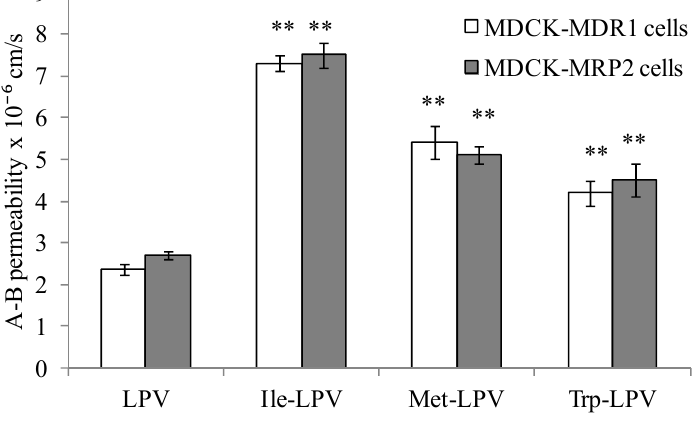
Figure 6. A–B permeability of LPV and prodrugs across MDCK-MDR1 and MDCK-MRP2 cells. Each data point is expressed as mean ± standard deviation (n = 4). Asterisk (**) represents significant difference from the control (LPV) ( p <